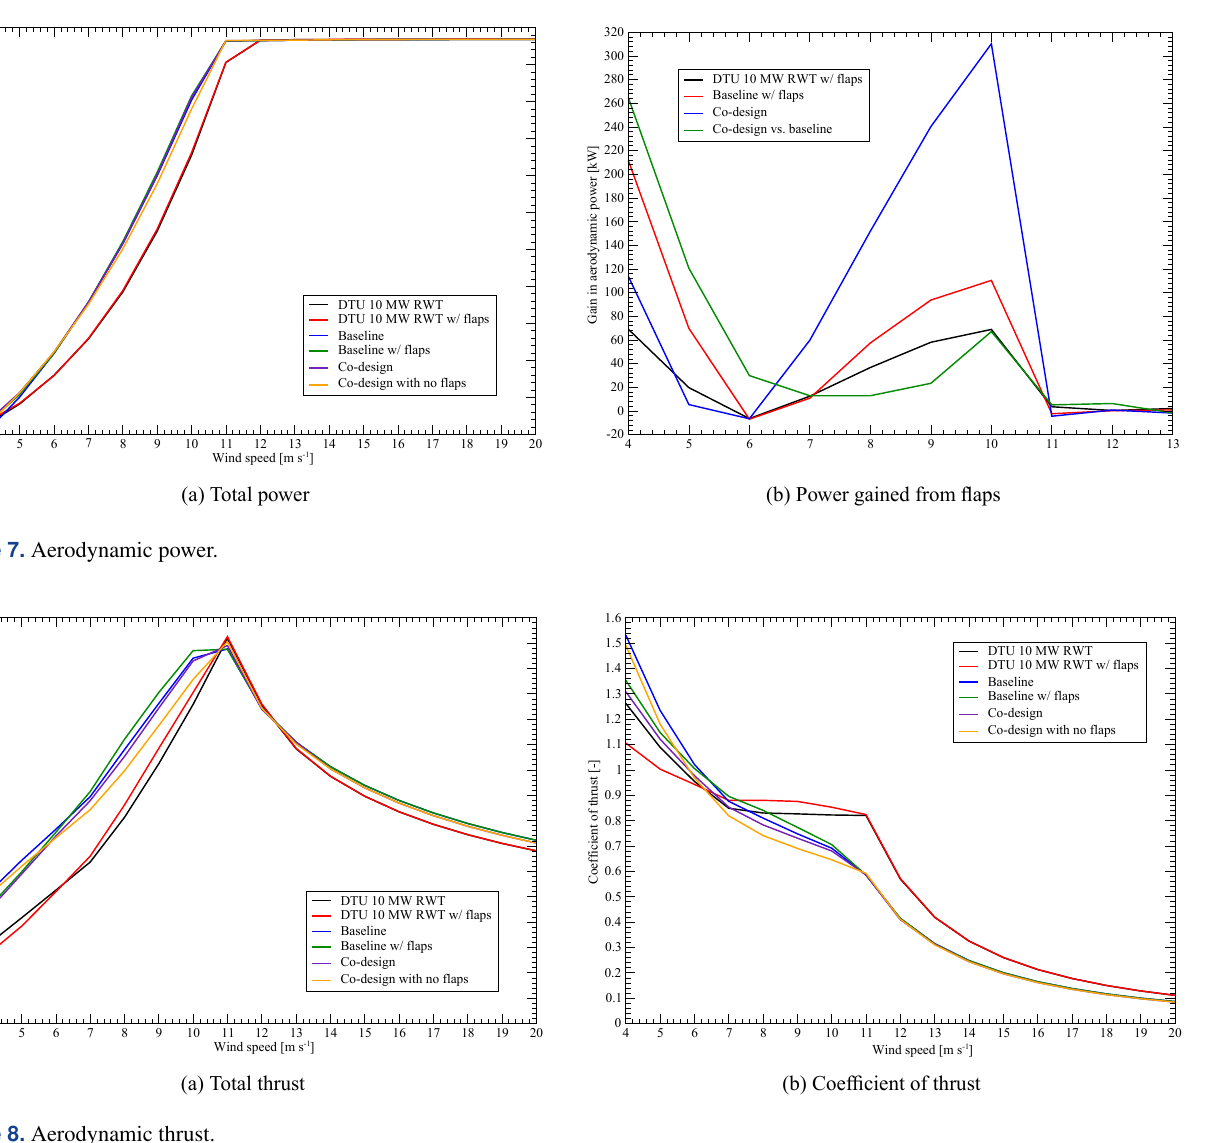
Figure 8. Aerodynamic